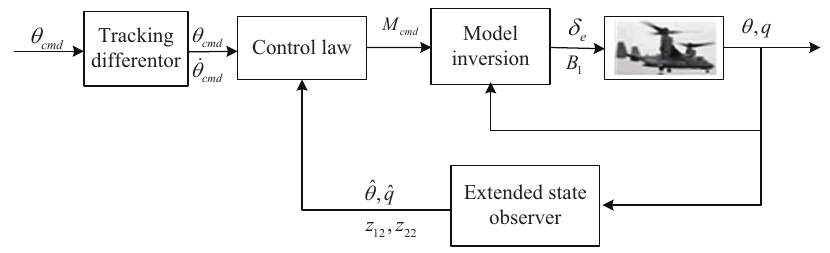
Figure 7. Attitude control block diagram of inner loop in conversion flight